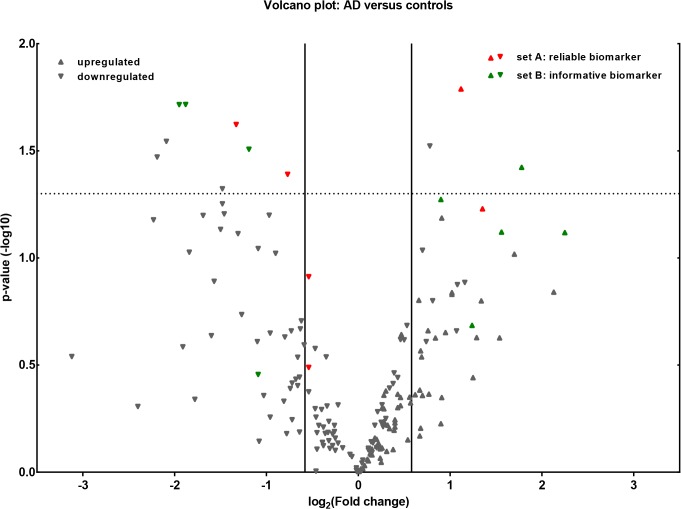
Volcano plot of group comparisons.Comparisons of 199 miRNAs assessed in OpenArray analysis of smallRNA isolated from CSF of patients with AD (n = 22) and controls (n = 28). The volcano plot displays the relationship between fold change and significance between the two groups, applying a student’s t-test. The y-axis depicts the negative log10 of p-values of the t-tests (the horizontal slider at 1.3 corresponds to a p-value of 0.05, a higher value indicates greater significance) and the x-axis is the difference in expression between the two experimental groups as log2 fold changes (vertical sliders indicate miRNAs as either up- or down regulated above a fold change of 1.5). Highlighted in green are the most reliable (6 abundant miRNAs from set A with RF≥0.8) and in red the most informative (9 less abundant miRNAs from set B above the critical MoR value d = 0.57) biomarkers according to the MoR-method (see Figs 2 and 3).